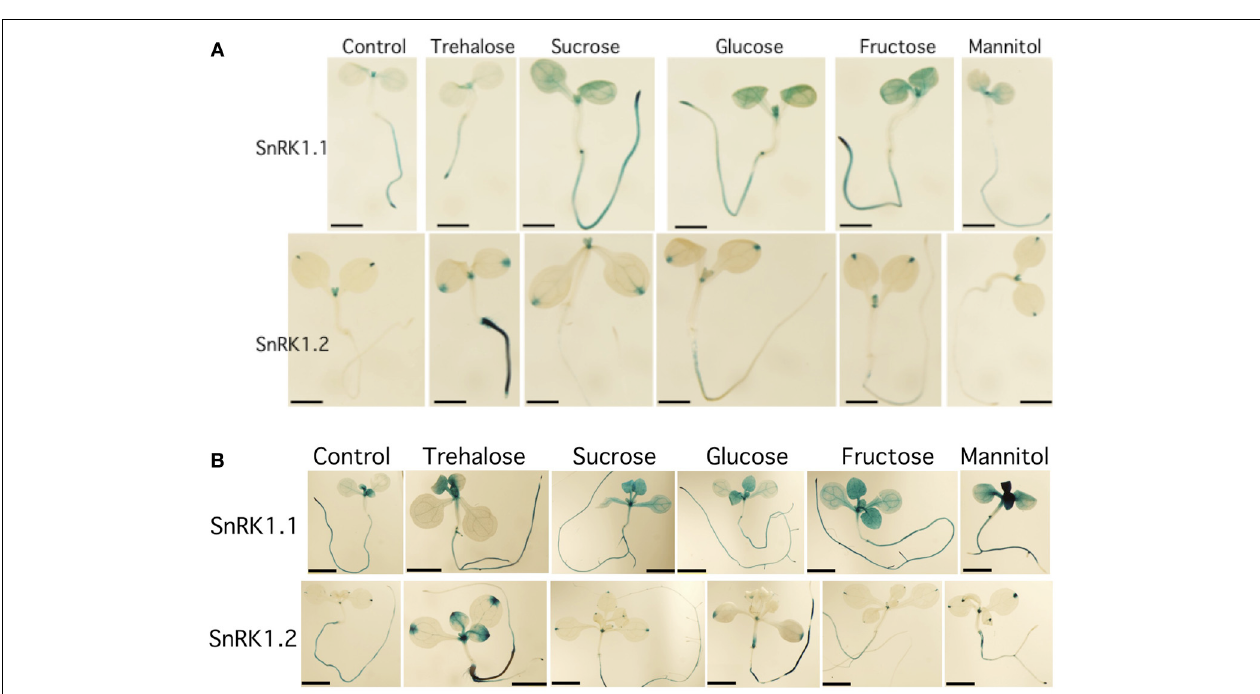
cotyledons, bar = 1mm. (C,D) 5d roots, bar = 100 μ M. (E,F) 10d leaf primordia, bar = 100 μ M. (G,H,K) 15d plants and roots, bar = 2mm. (I,J) 10d roots, bar = 100 μ M; (L,M) siliques, (N,O) developing seed, bar = 500 μ M. The red arrows indicate small areas which are positive for staining.